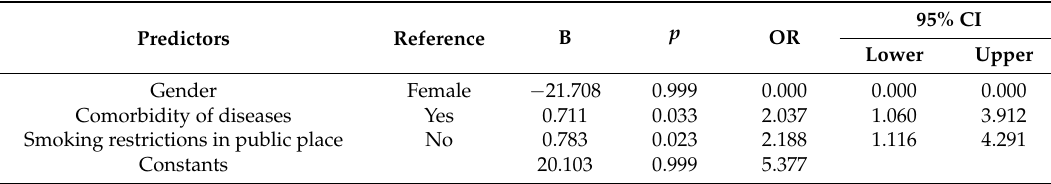
Table 5. Outcome of logistic regression analysis for examining predictors correlated with success in quitting